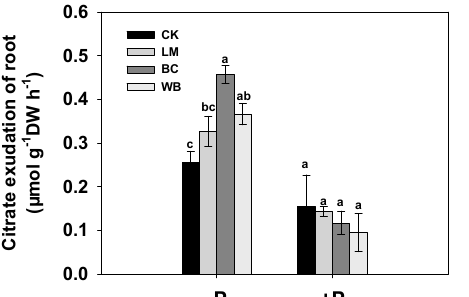
Figure 2. Effect of biochar and P supply on the exudation rate of citrate in the rice roots. Each value is the mean ± standard error of four replicates. Different letters indicate means that differ significantly ( p < 0.05). The treatments were: CK: the control treatment; LM: lime equivalent to a biochar application rate of 20 g kg − 1 ; BC: biochar at an application rate of 20 g kg − 1 ; WBC: washed biochar at an application rate of 20 g kg − 1 .